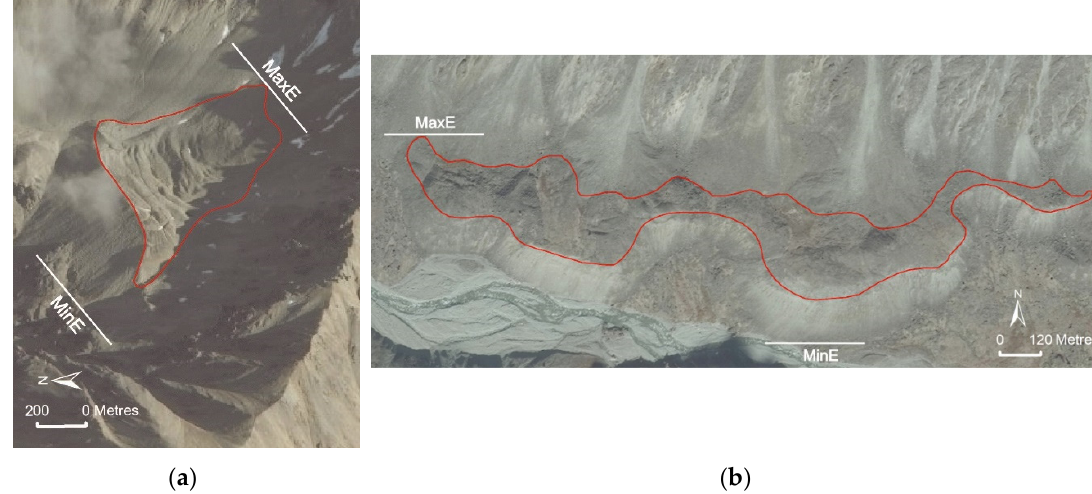
Figure 2. Example of deciphering (red line) the surface of cirque ( a ) and sloping rock glaciers ( b ), measuring the minimum (MinE) maximum (MaxE) elevations.